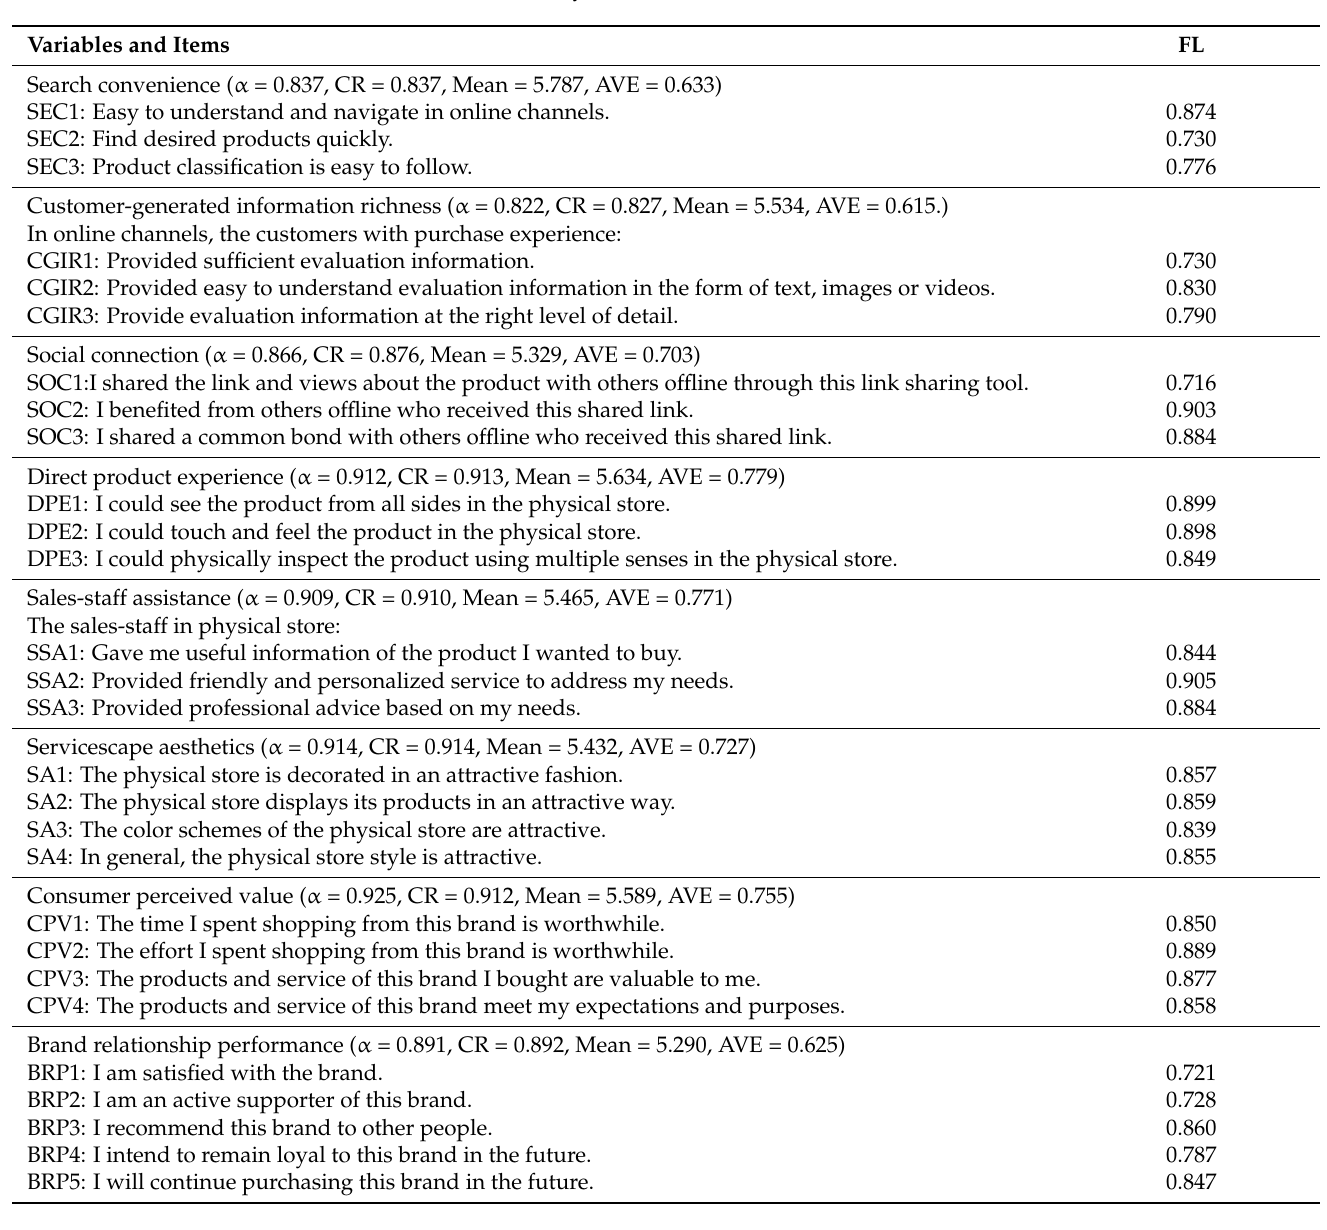
Table 4. Measures of key